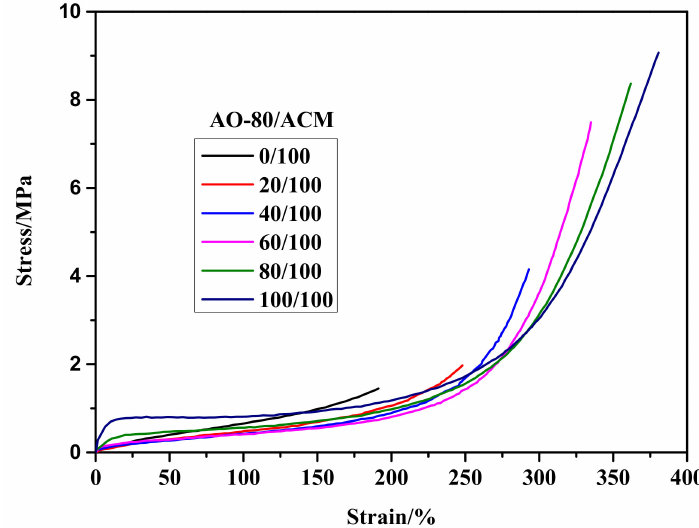
Figure 5. Stress-strain curves of ACM and AO-80/ACM rubber